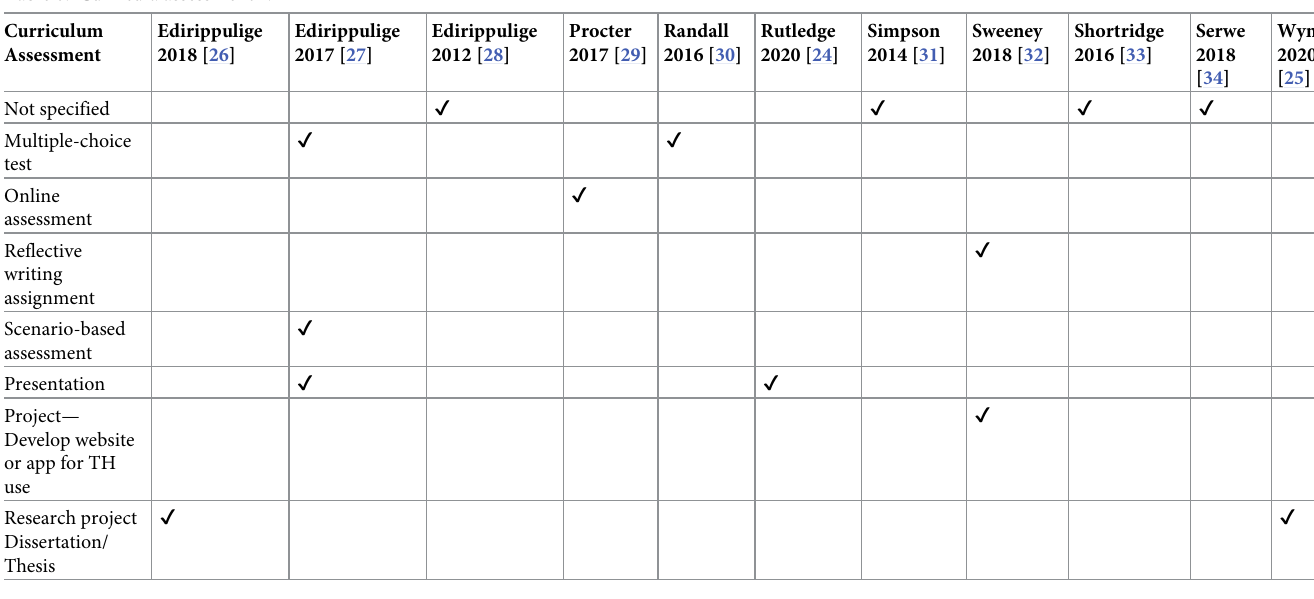
Table 6. Curricula assessment �